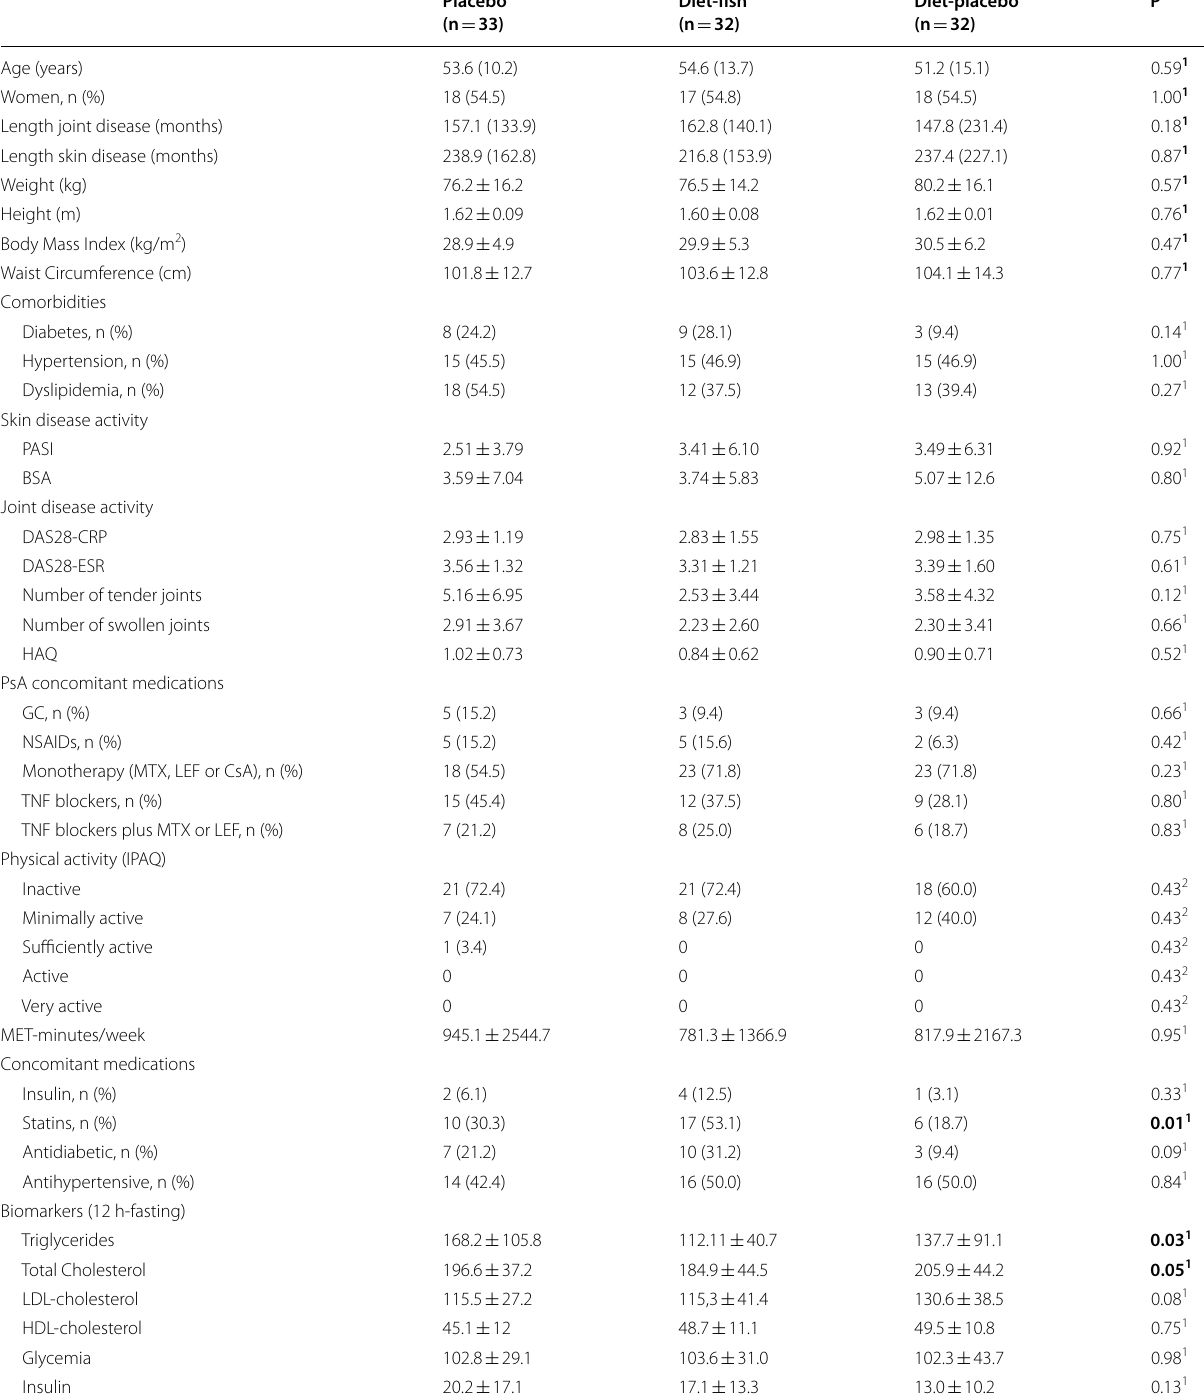
Bold indicates p statistically significant (